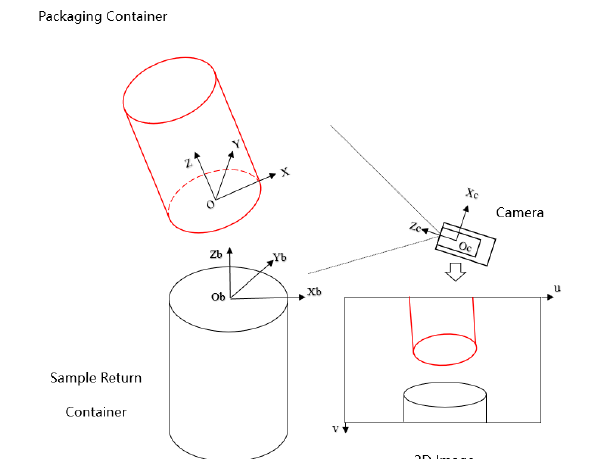
Figure 1. Coordinate systems definition